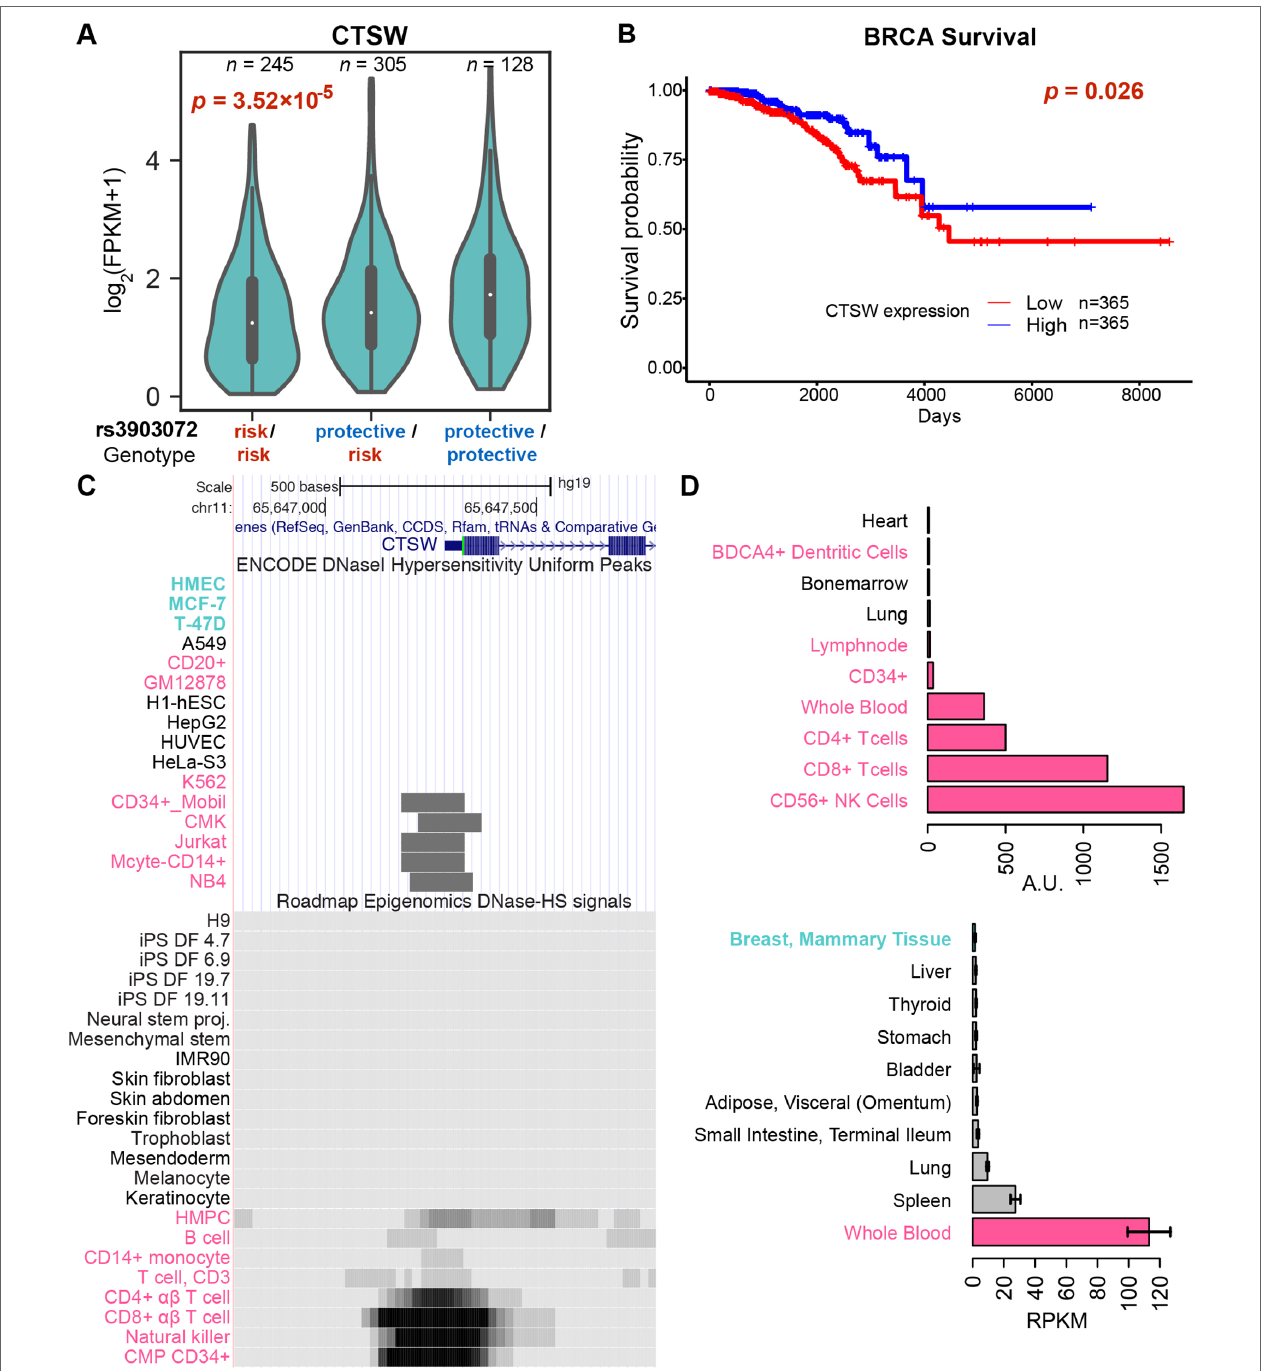
FIGURE 2 | Genotype-dependent suppression and tissue specificity of CTSW expression. (A) The violin plot of CTSW expression levels in three genotype groups at rs3903072, using the TCGA ER+ breast cancer patient data. The p -value is for the coefficient of genotype in multivariate linear regression with adjustment for gene copy number. (B) Survival analysis of breast cancer patients based on CTSW expression levels. The p -value is from the log-rank test using the two groups separated by the median expression of CTSW . (C) The CTSW promoter chromatin accessibility in multiple cell lines from various tissue origins. The top ENCODE plot shows the DNase I hypersensitivity (DHS) uniform peaks in ENCODE tier 1 cell lines, along with the tier 2/3 cells in which CTSW promoter is open. The bottom plot shows the DHS signals for primary cells from Roadmap Epigenomics data. Cells with breast tissue origin are marked as cyan, and blood-related normal or cancer cells are marked as magenta. HMPC, hematopoietic multipotent progenitor cells; CMP CD34+, common myeloid progenitor cells CD34+. (D) Distribution of CTSW expression in cell lines and in tissues. The top figure shows data from BioGPS, displaying only 10 cell types with highest CTSW expression. The bottom figure shows data from GTEx, displaying only nine tissue types with highest CTSW expression and mammary tissue (ranked